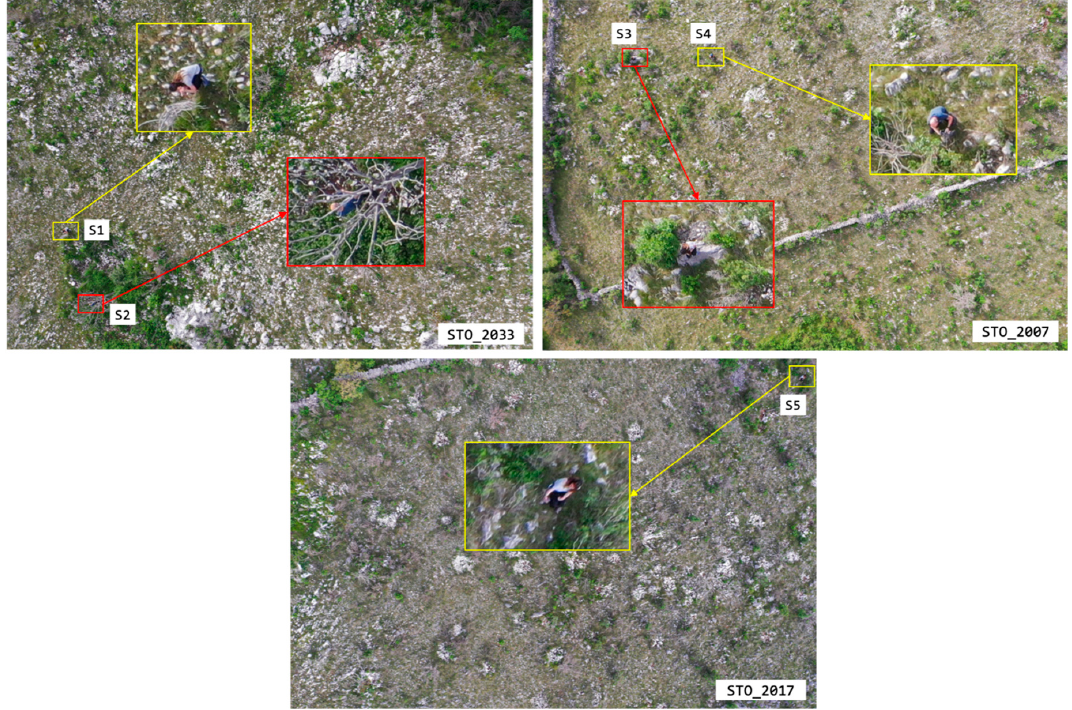
Figure 18. The most difficult examples in missions (mission Stolac 2) with the ScoreMap to ROI support.